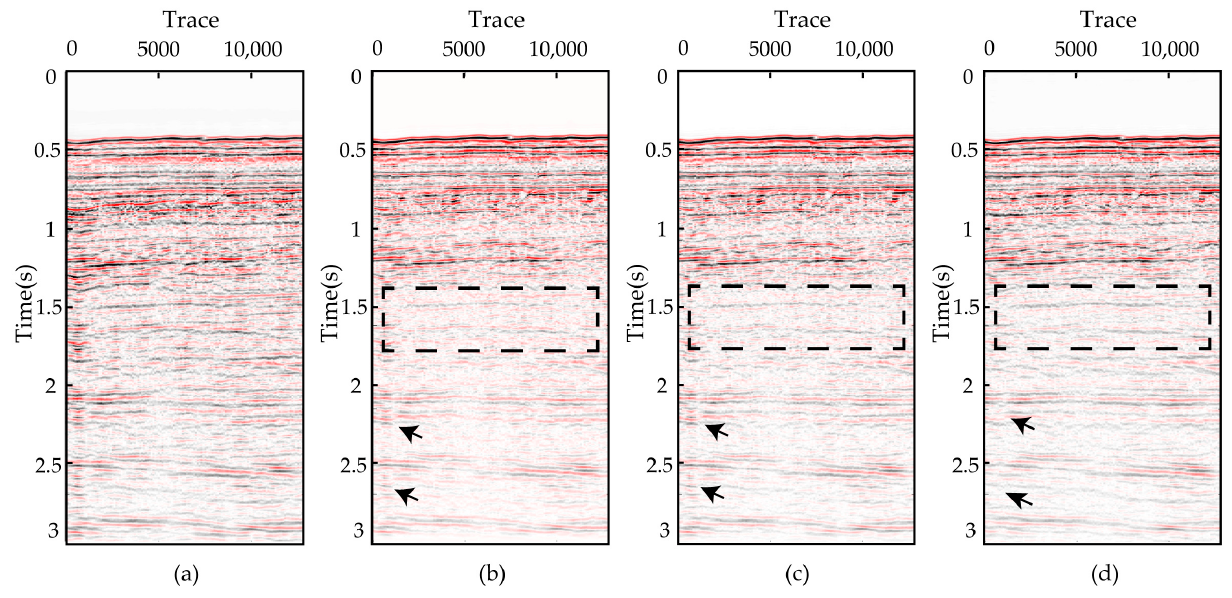
Figure 11. Multiple attenuation result: ( a ) stacked real data; ( b ) LSPRT method; ( c ) SPRT L 1 method; ( d ) SPRT L q 1 − L q 2 method. The black arrows indicate the continuity of the seismic events are improved in the Figure